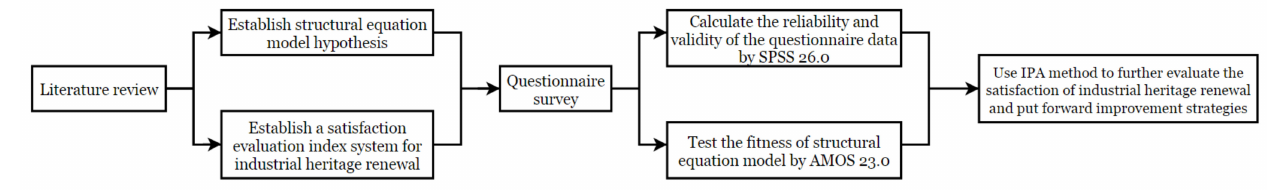
Figure 1. Research